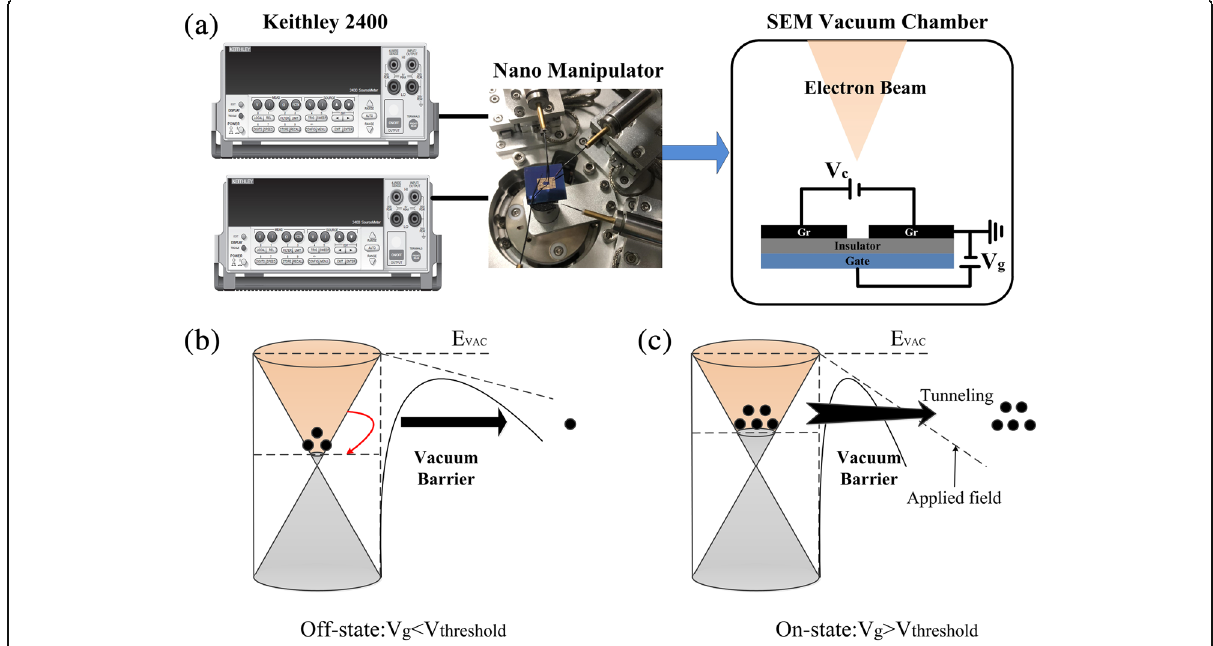
Fig. 5 In-situ field emission measurement of the graphene-based vacuum nano-channel transistor ( a ). Band diagram of graphene-based NVCT at V V V V g < threshold and g > threshold ( b , c